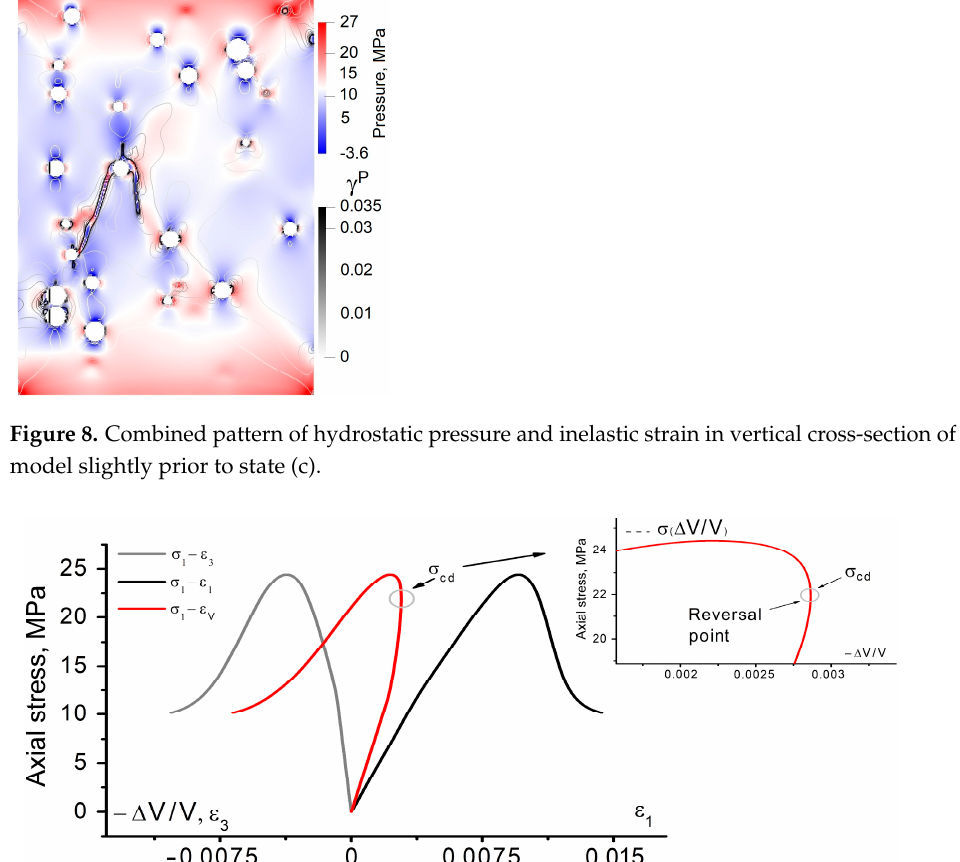
Figure 8. Combined pattern of hydrostatic pressure and inelastic strain in vertical cross-section of the model slightly prior to state (c).